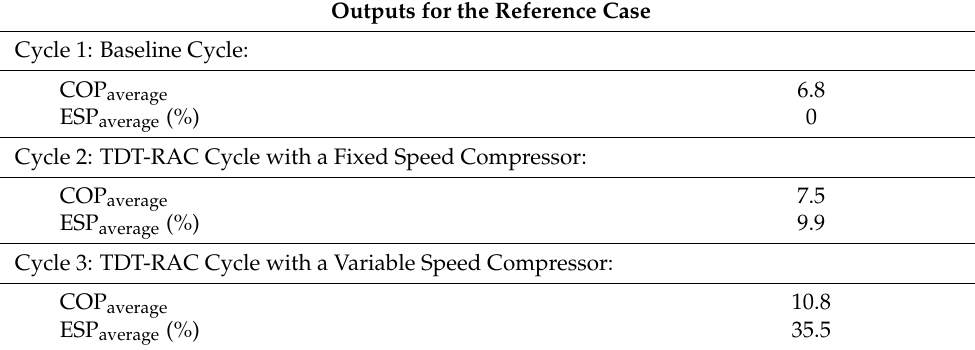
Outputs for the Reference